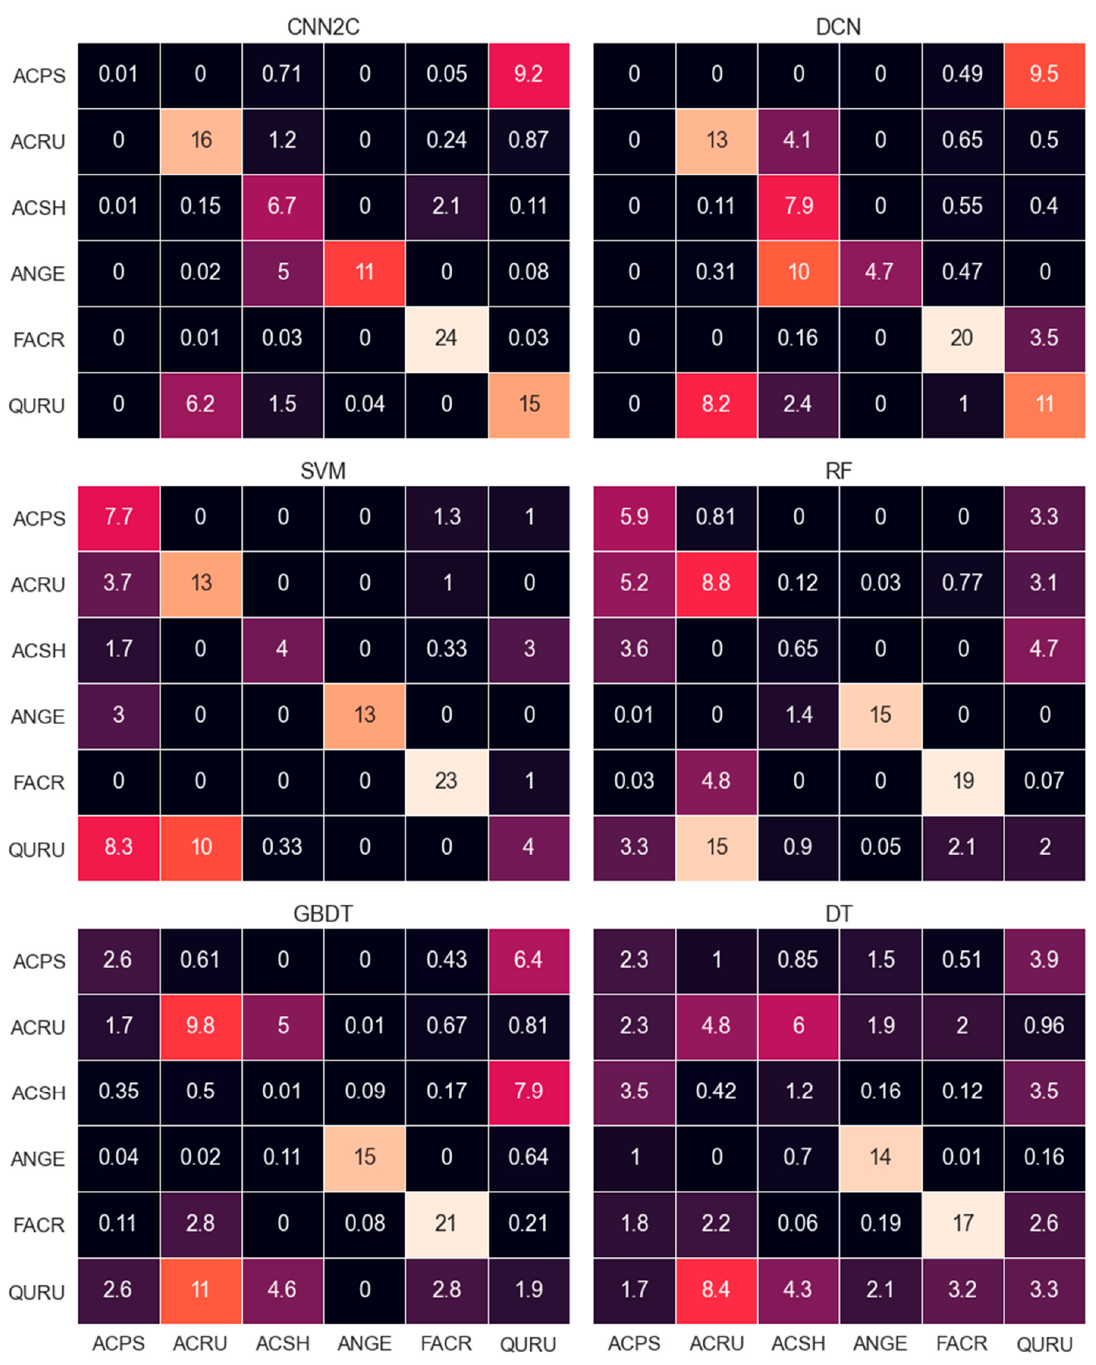
Figure 6. Confusion matrices for comparison models. Rows and columns indicate correct and predicted labels, respectively. For data sources of these species, refer to Table 1. The value of each species is the average prediction of 100 models of each method.